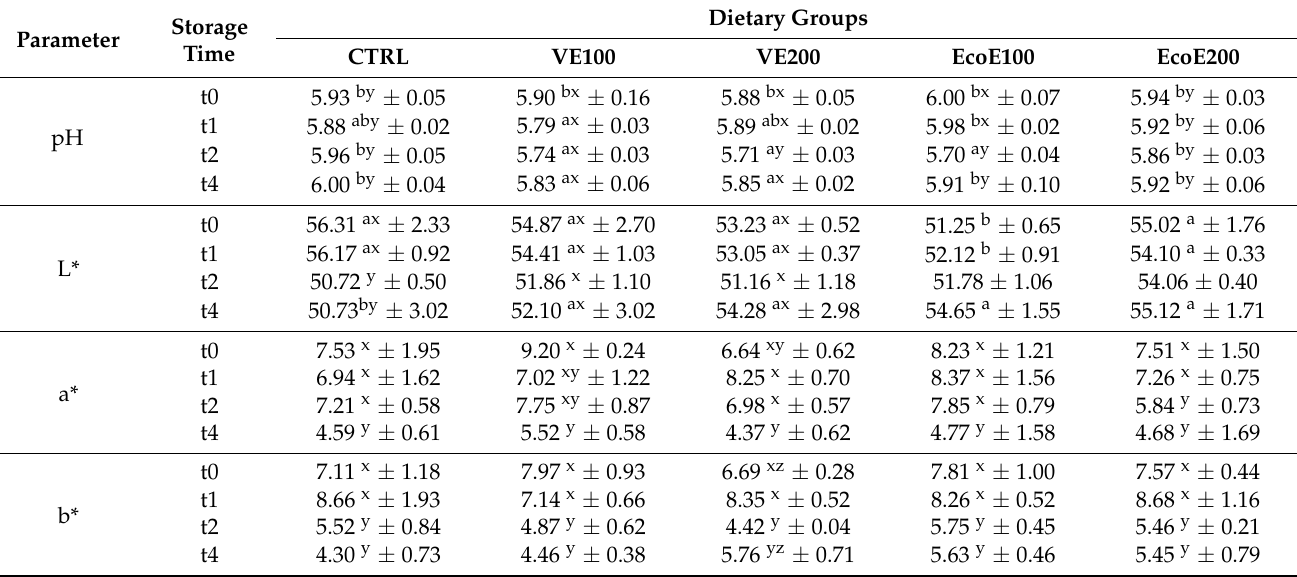
Table 5. The effects of dietary supplementation with α -tocopheryl acetate (VE) or EconomasE TM (EcoE) and storage time on the pH and colour parameters (L*, a*, b*) of packaged rabbit hamburgers.